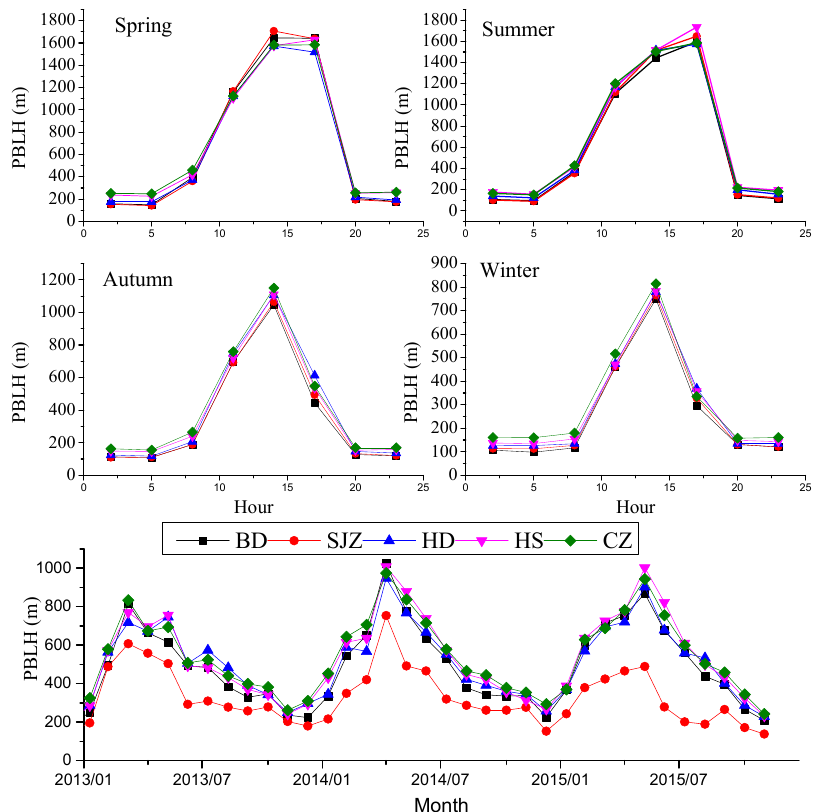
Figure 3. Diurnal and monthly variations of average planetary boundary layer height (PBLH) in five cities during 2013–2015.